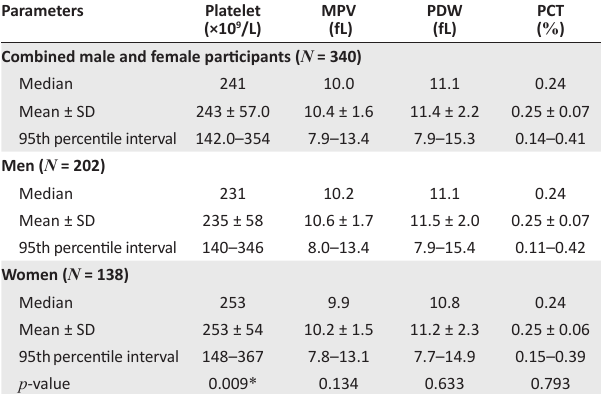
TABLE 4: Platelet parameter reference intervals of healthy adults stratified by sex, Bamenda, Cameroon, April-September 2015. Parameters Platelet (×10 9